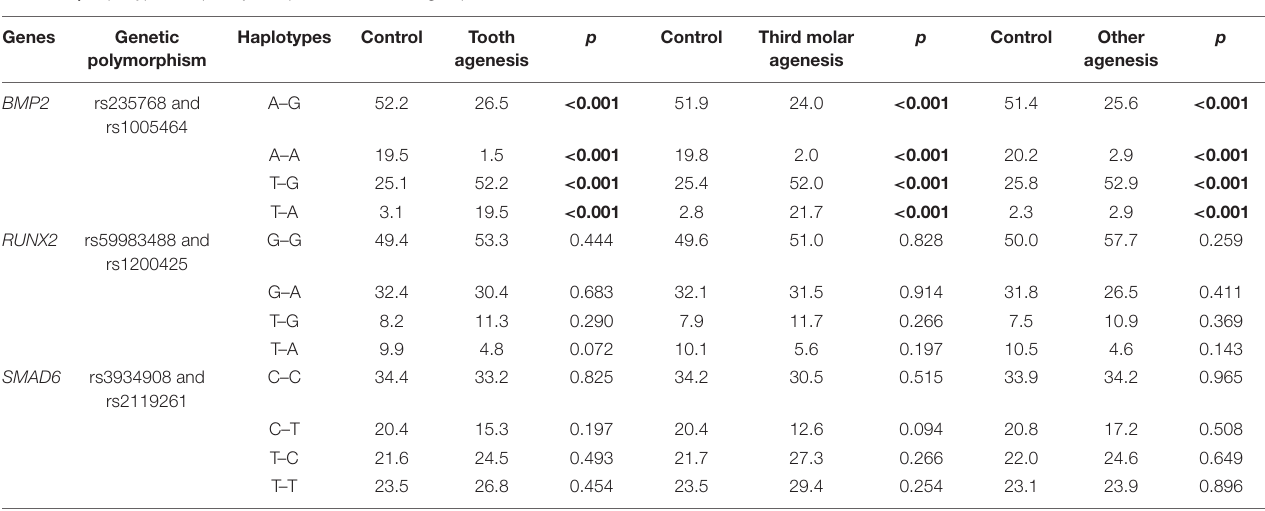
TABLE 3 | Haplotypes frequency comparisons between